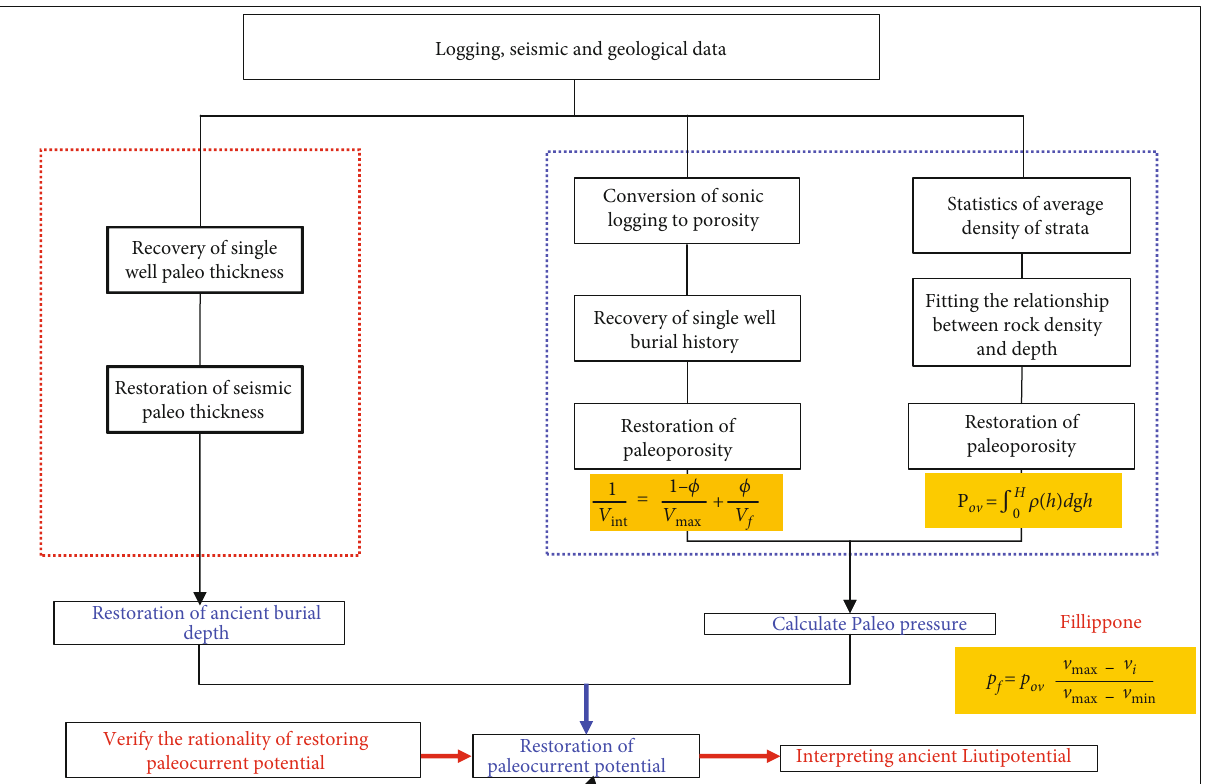
Figure 5: Flow chart of paleo fl uid potential